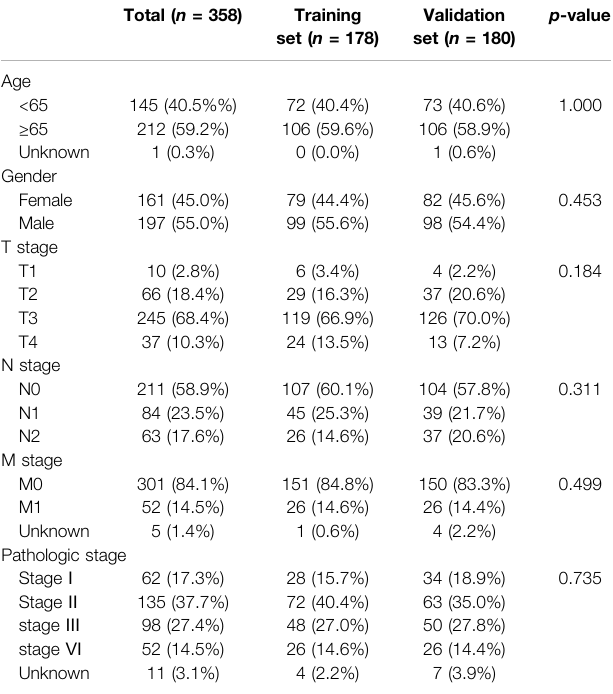
TABLE 1 | Characteristics of patients in the training and validation set.